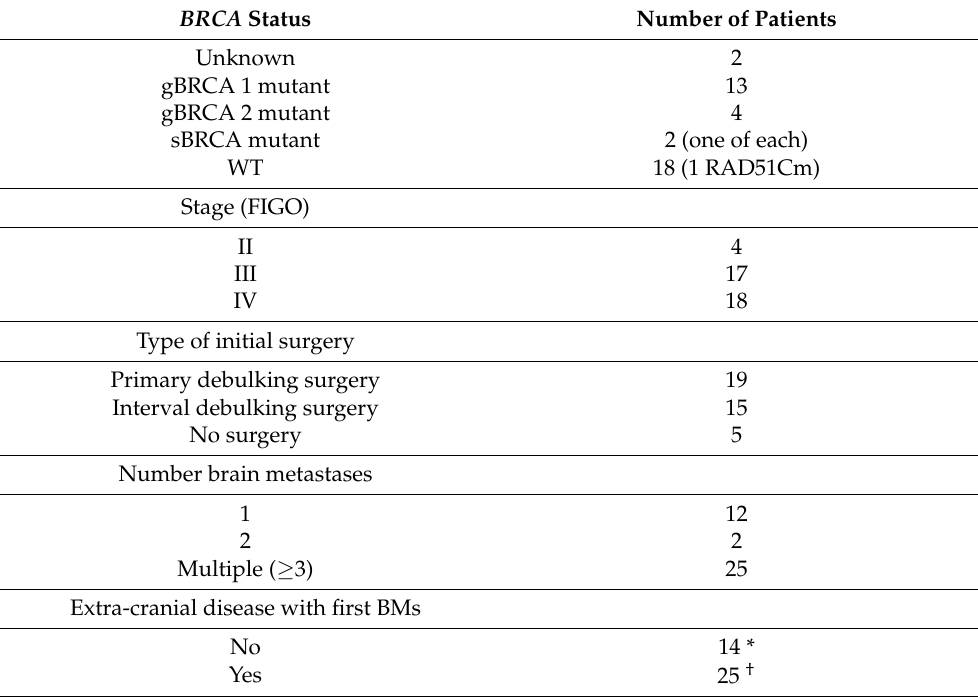
Table 1. Baseline clinical characteristics of 39 patients with EOC and